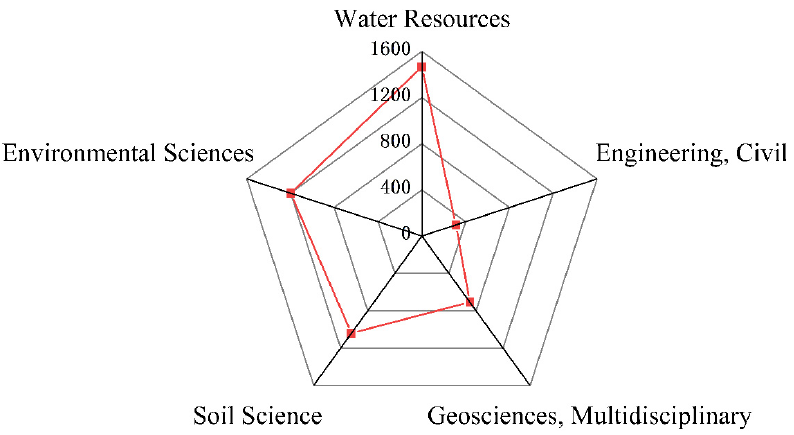
Figure 8. Top 5 fields with the most publications on preferential flow from WoS database.